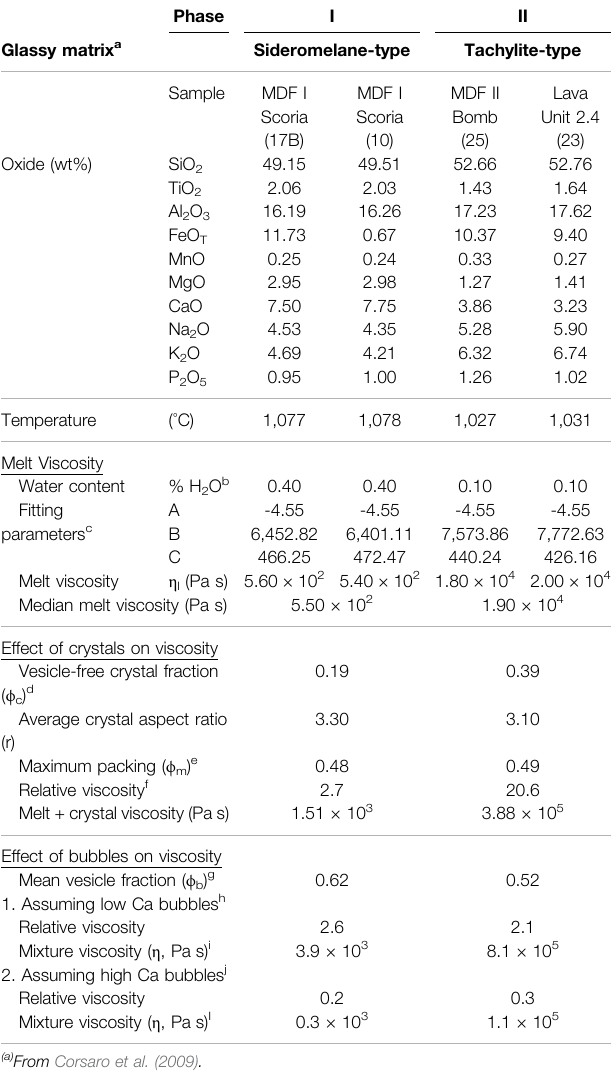
TABLE 5 | Glass chemistry, eruption temperatures and derivation of viscosity for Phase I and II samples.